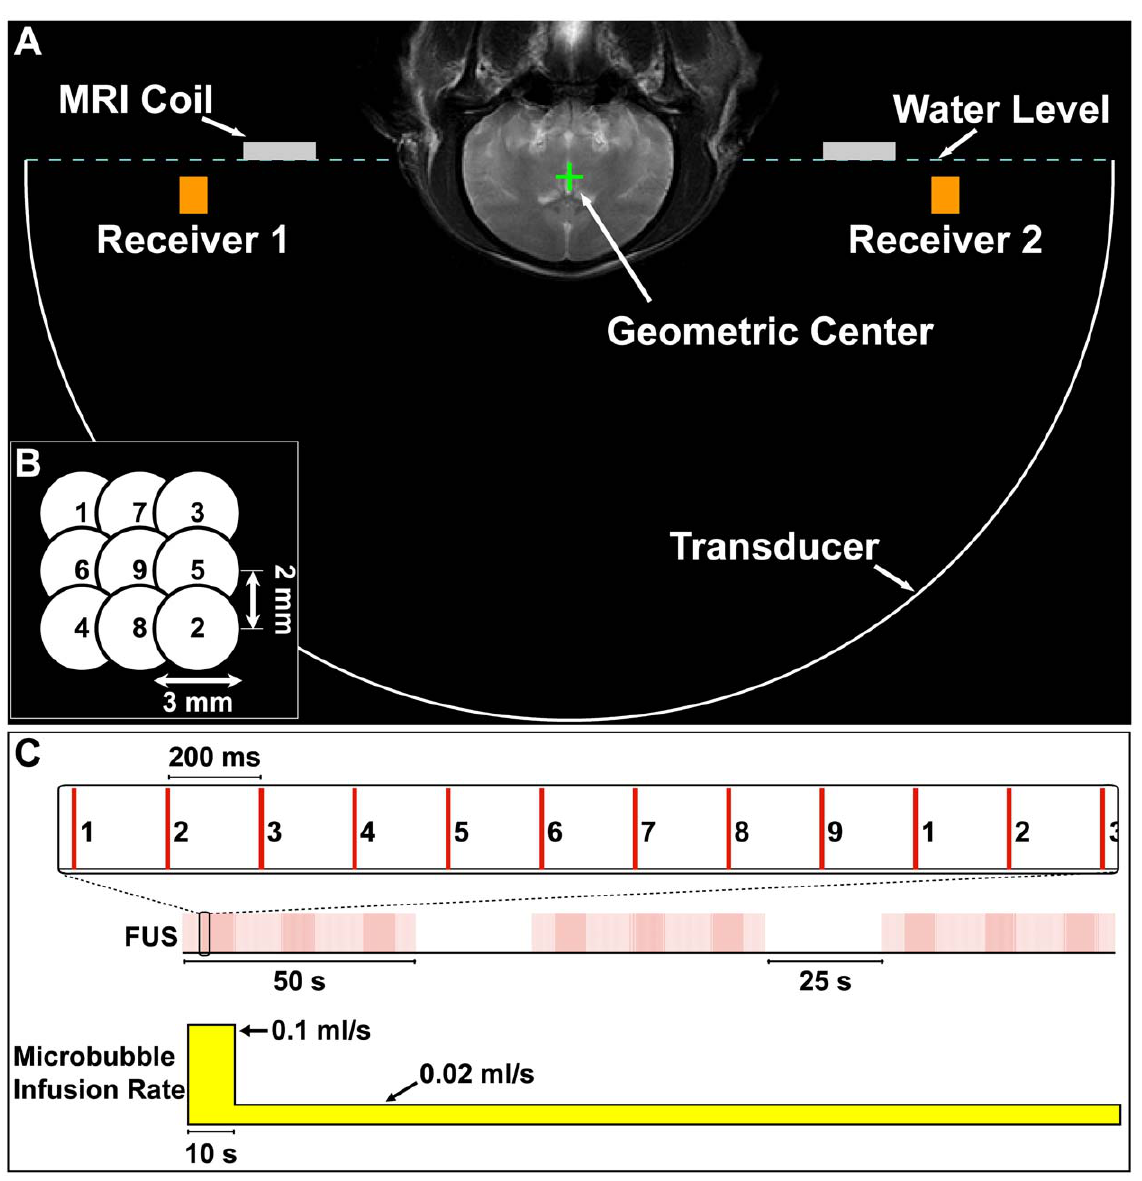
Figure 1. Experimental setup and methods. (A) Coronal T2-weighted MRI of a monkey obtained during one of the experiments. The image has been annotated to show the location of the 30 cm diameter hemisphere transducer, the two transducers that served as receivers to monitor the acoustic emissions, and the MRI surface coil. The annotations were drawn to scale with the location of the brain in a typical position. (B) Beam steering pattern used during the multi-target sonications. The order of the sonications delivered is indicated. (C) Pulsing scheme used during the multi-target sonications. Each 10 ms burst was applied in sequence to the different subsonication targets every 200 ms. The pattern was repeated every 1.8 s, resulting in a pulse repetition frequency at each target of 0.55 Hz. Three 50 s sonications were delivered in series using this pattern, with a 25 second delay between sonications. The microbubbles were administered as an infusion that was started at the beginning of the each multi- target sonication, as indicated. This infusion was delivered at a variable rate in order to quickly reach a steady-state microbubble concentration in the tissue and maintain it throughout the entire sonication.